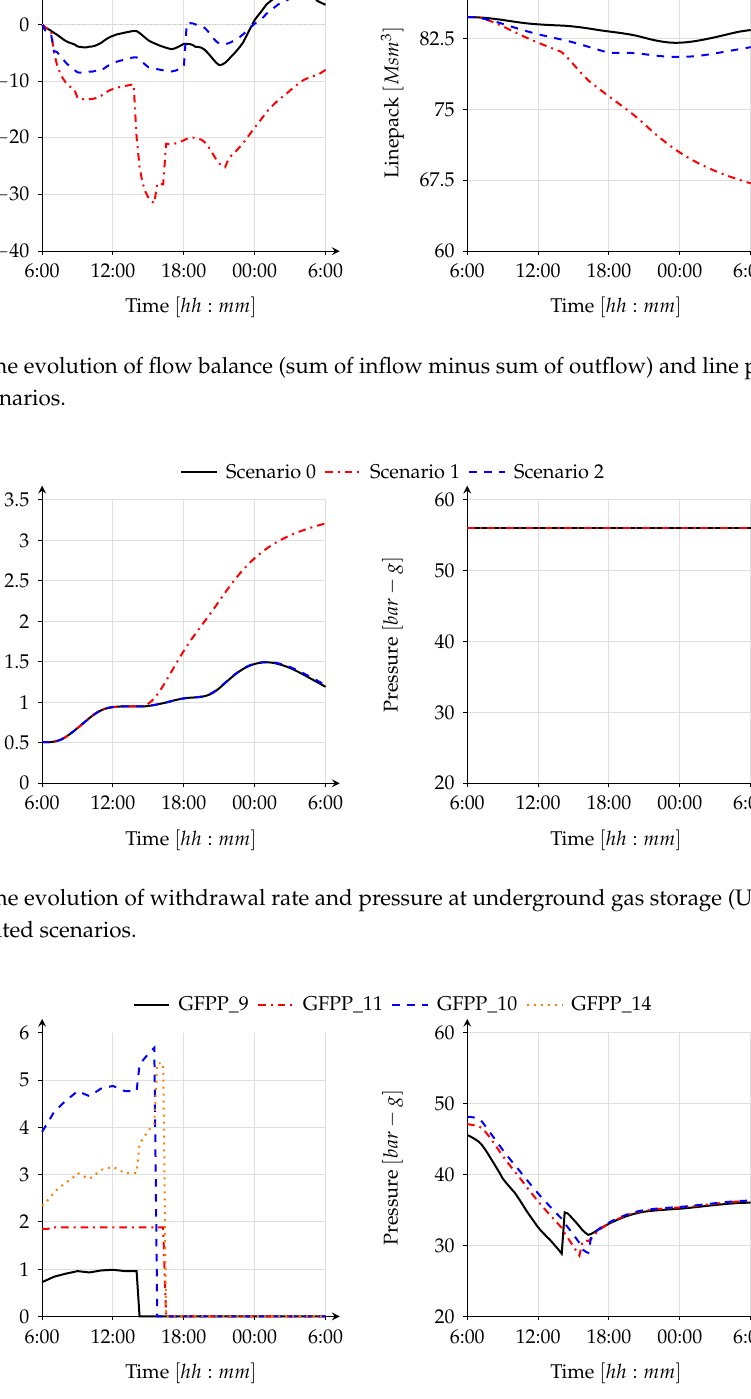
Figure 13. Time evolution of load and pressure of failed GFPPs in scenario